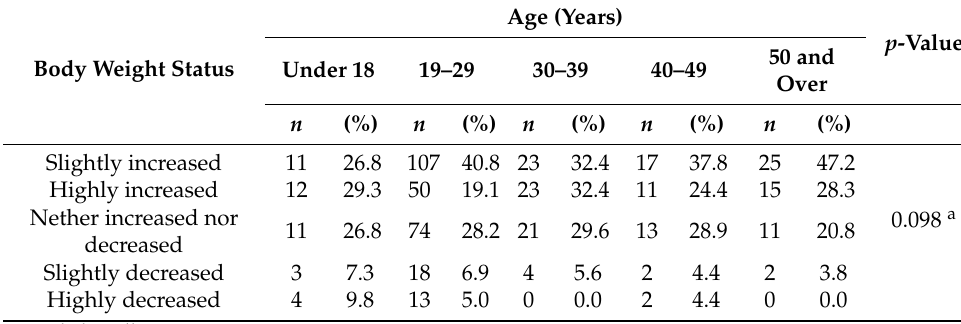
Table 4. Comparison of the body weight status and age during the full COVID-19 curfew period.